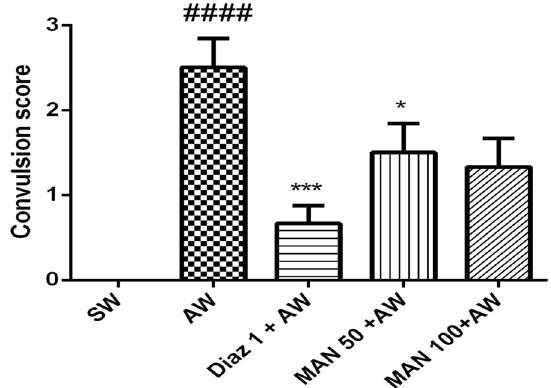
Fig. 1 Effect of MAN (50 and 100 mg/kg p.o.) on alcohol withdrawal-induced handling convulsion in mice. Convulsion scores are expressed as MEAN SEM ( n 6); #### P < 0.0001 when compared ± = with the saline withdrawal group; * P < 0.05 and *** P < 0.001